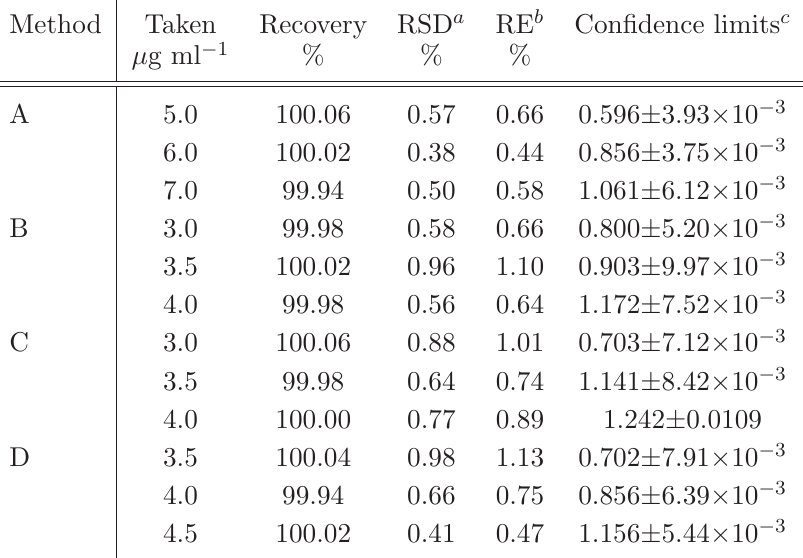
Table 4 Evaluation of accuracy and precision of the proposed methods with vancomycin